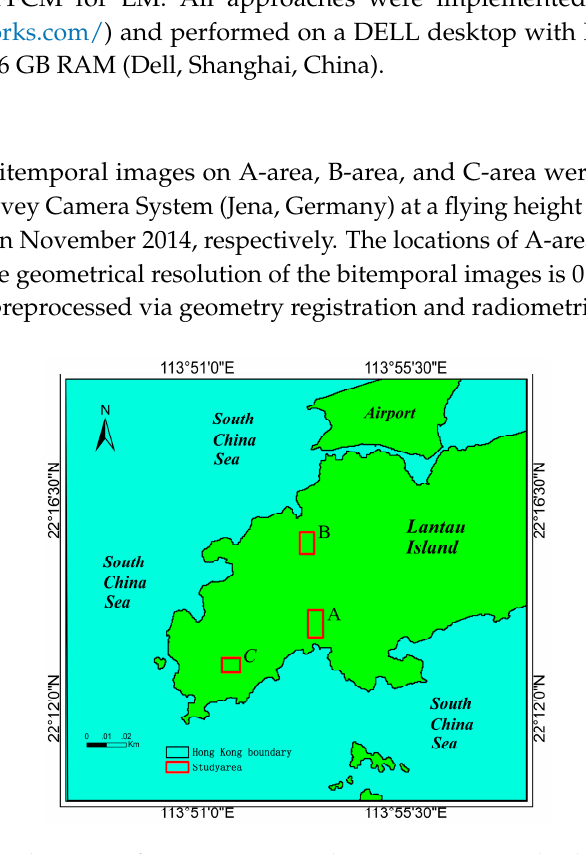
Figure 12. Study area locations of A-area, B-area, and C-area on Lantau Island, Hong Kong, China. A-area: Figure 13a,b shows the pre- and post-event images of A-area. The size of the bitemporal images was 1252 × 2199. The true boundaries of the landslides in the images were generated manually by human experts in the field of remote sensing, and they are shown in Figure 13c. Figure 13d shows the corresponding ground truth segmentation. B-area: Figure 14a,b shows the pre- and post-event images of B-area. The size of the images was 923 × 593. The ground truths, i.e., the boundaries and segmentation results of landslides in the post-event image, are shown in Figure 14c,d, respectively. C-area: Figure 15a,b shows the pre- and post-event images of C-area. The size of the images was 750 × 950. The ground truths, i.e., the boundaries and segmentation results of landslides in the post-event image are shown in Figure 15c,d, respectively.